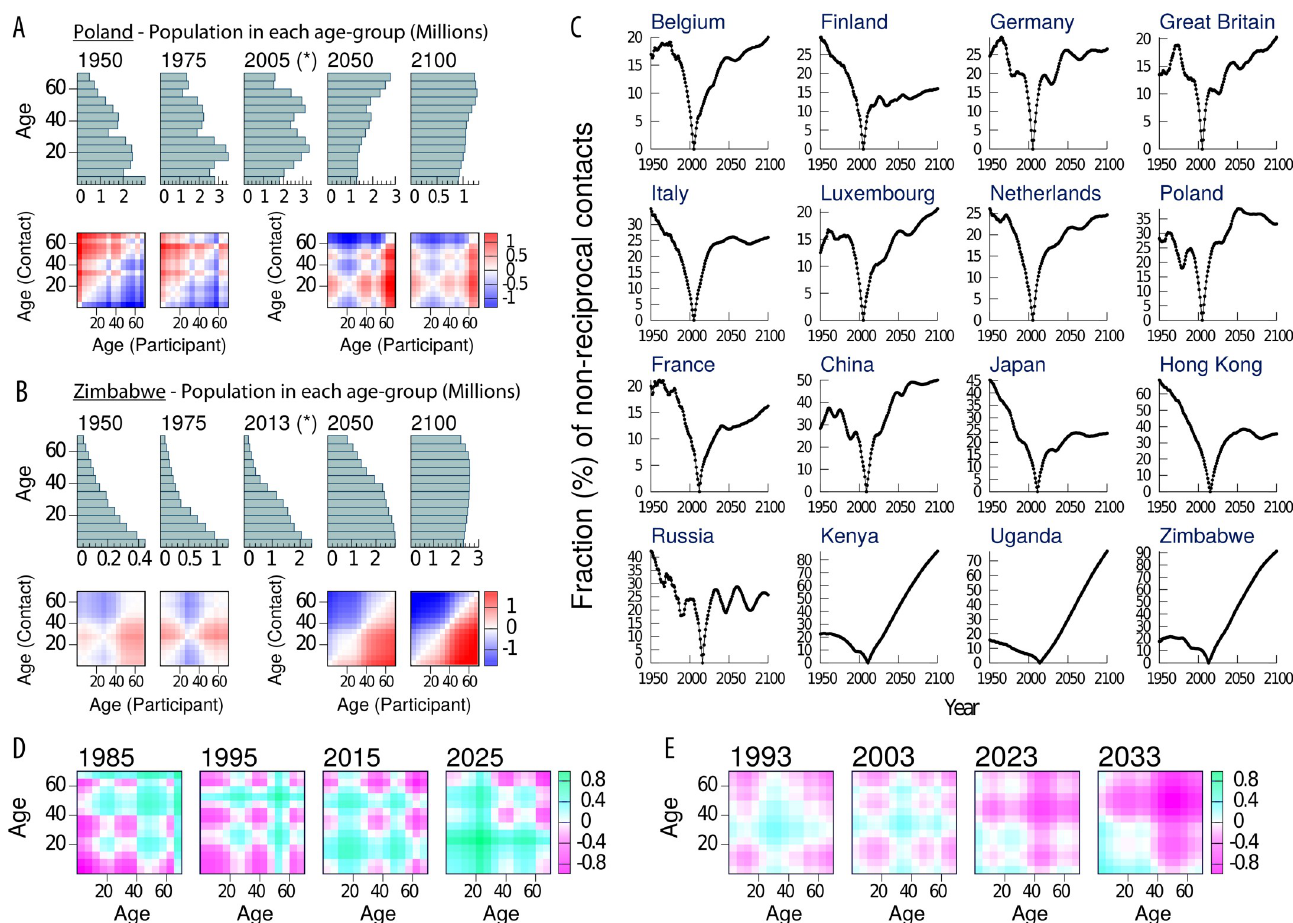
Fig 1. Analysis of methods M0 and M1. A-B: Demographic structures for different years and the respective non-reciprocal matrices NR 0 Zimbabwe respective using M0. C: Evolution of the total fraction of non-reciprocal contacts for M0 in the 16 geographic settings analyzed in this study. D-E: � � 0 for Poland and Zimbabwe respectively, in four different years (10/20 years before/after the measurement of the contact patterns) for M1. The original i ; j log 2 G G i ; j data corresponds to 2005 for Poland and 2013 for